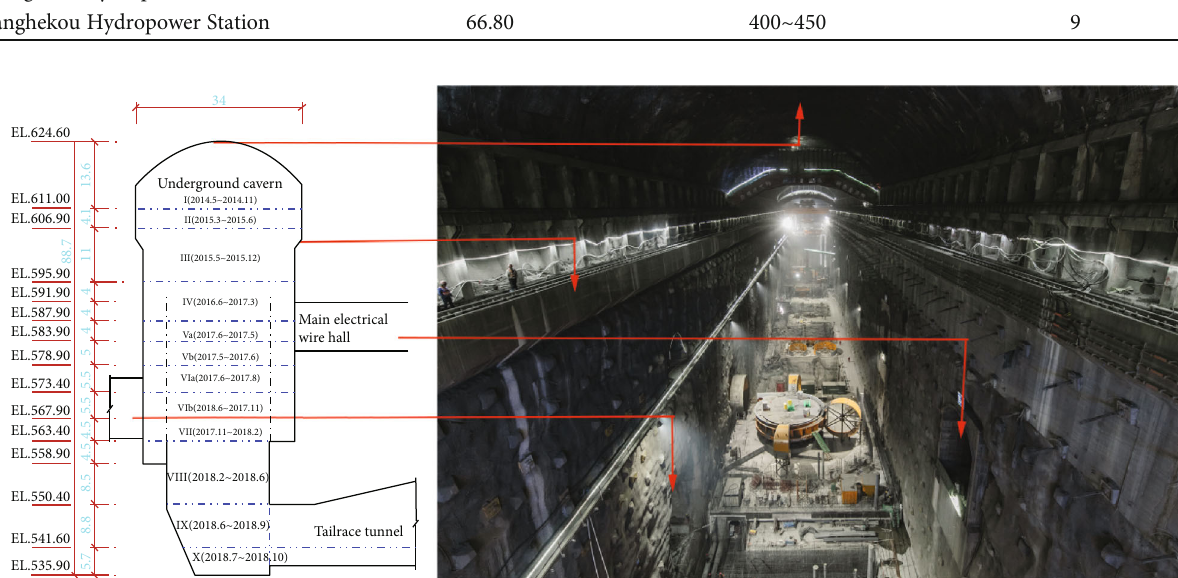
Figure 1: Schematic diagram of the layered excavation of large-scale underground caverns (Baihetan Hydropower Station).